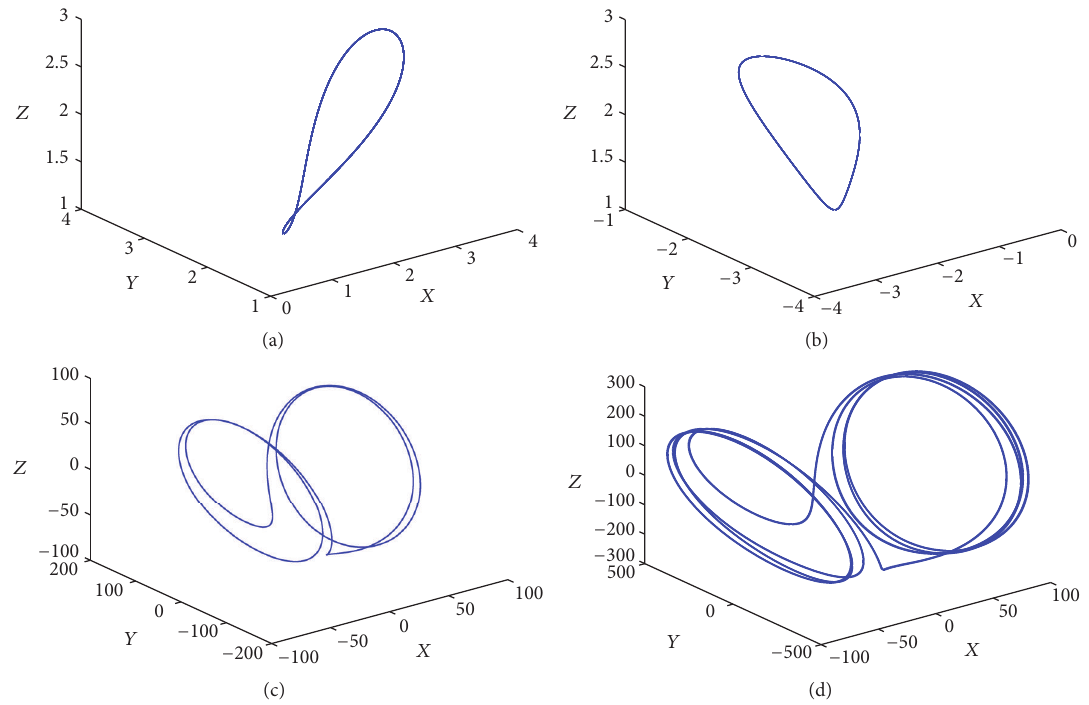
Figure 9: Coexisting limit cycles for {𝑎 = 40 and 𝑑 = 7} . Initial conditions: (a) (150, 2,1, 45) , (b) (0.1, 0.1, 0.1, 0.1) , (c) (100, 50, 50,100) , and (d) (200,300, 200, 350)